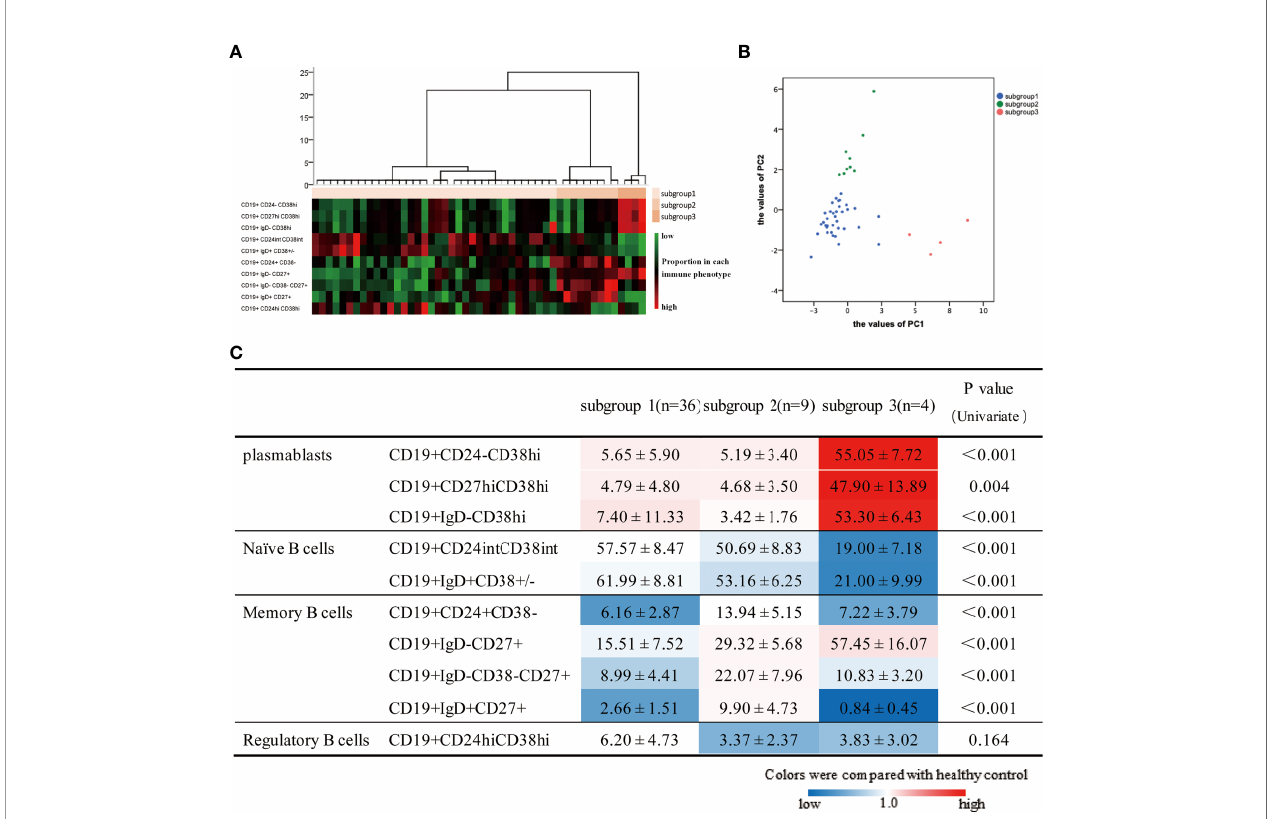
FIGURE 4 | Results of cluster analysis based on 10 B-cell phenotypes in patients with active IgG4-RD. (A) Hierarchical statistical clustering of IgG4-RD patients. (B) PC1 and PC2 values in individual patients in the 3 three subgroups. (C) B-cell subset ratios in 3 three subgroups are shown. Values are the mean ± SD, with levels that were signi fi cantly different in the patient subgroup compared with the healthy control group highlighted in color (blue for decreased; red for